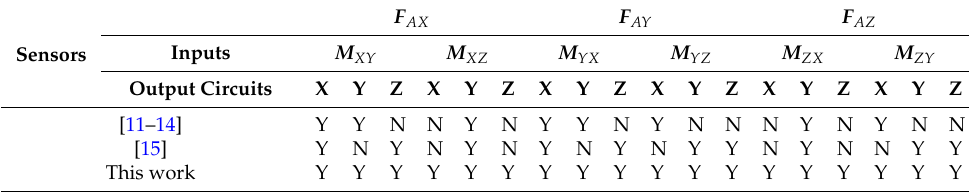
Table 1. The comparison of extra moment interference between different sensor structures.